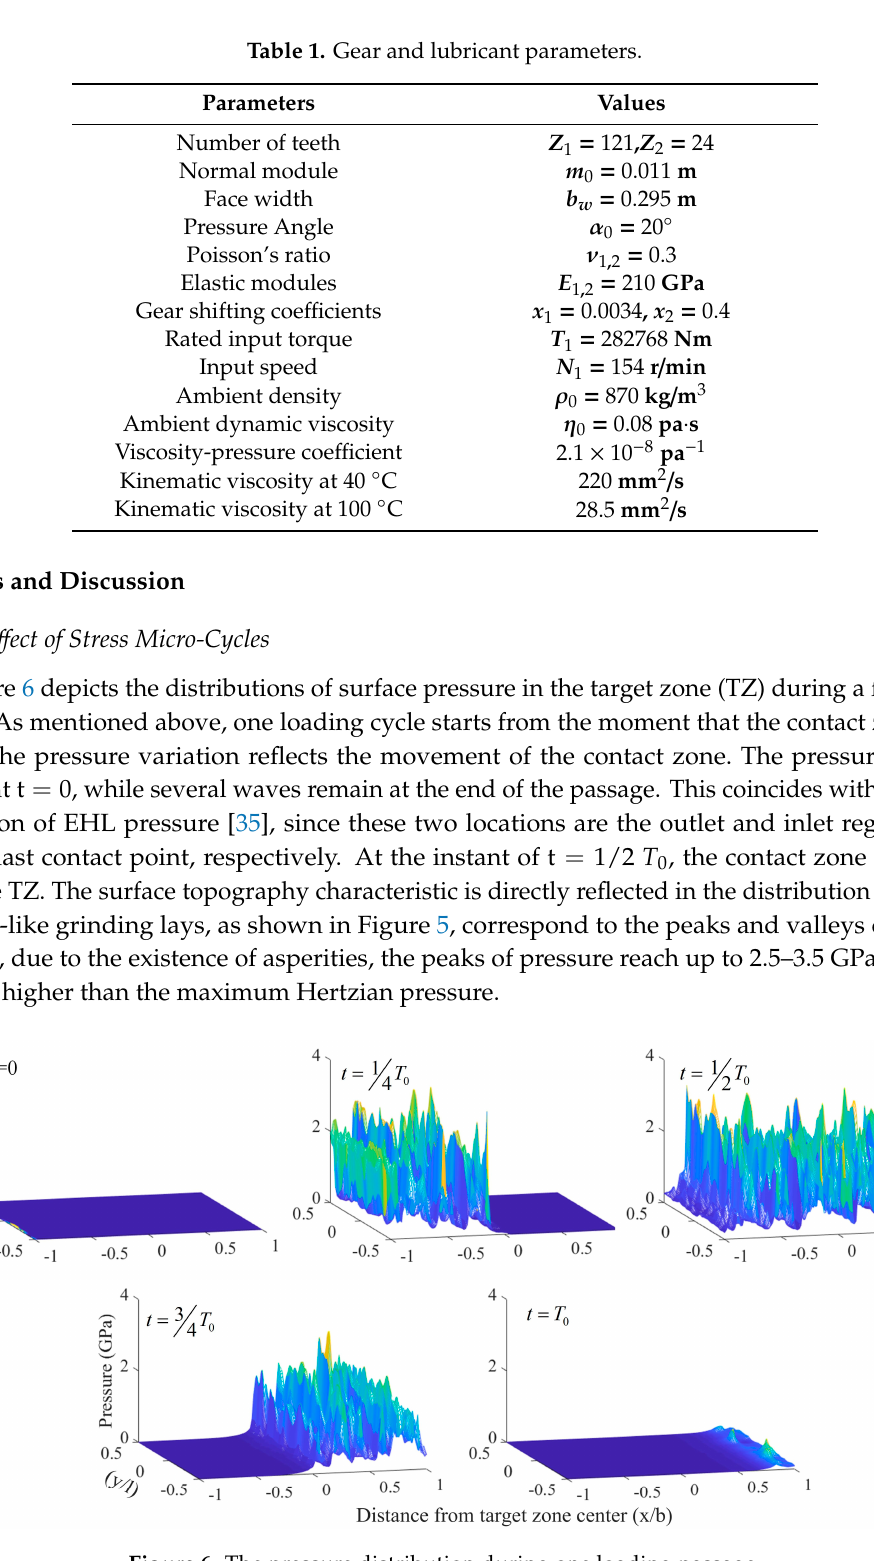
Figure 6. The pressure distribution during one loading passage.